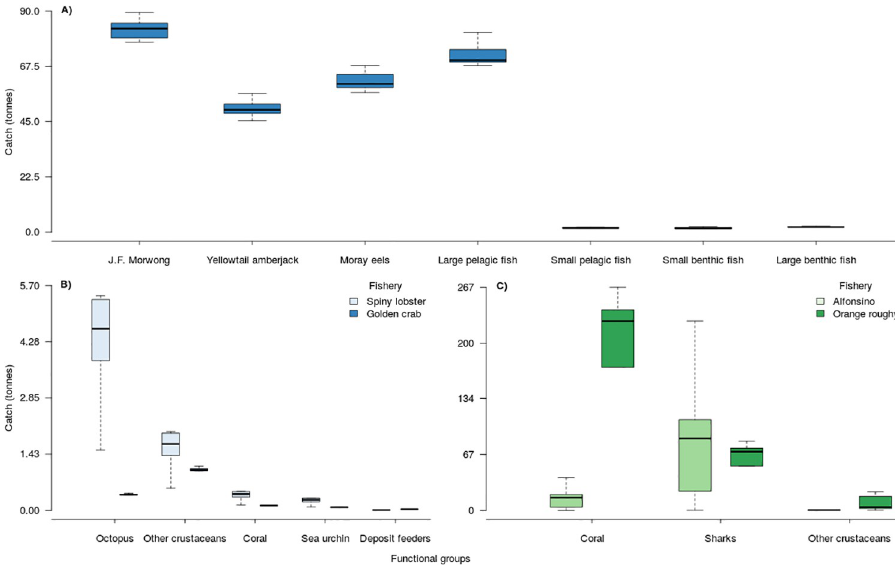
Fig 6. Summary of the catch distribution for the total bait caught from artisanal fisheries (A)), the total artisanal bycatch (B)) and the industrial bycatch (C)). The upper and lower limits of boxes represent the 25 th and the 75 th percentile and the middle line the 50 th percentile of the data distribution. The whiskers represent the range of the catches.